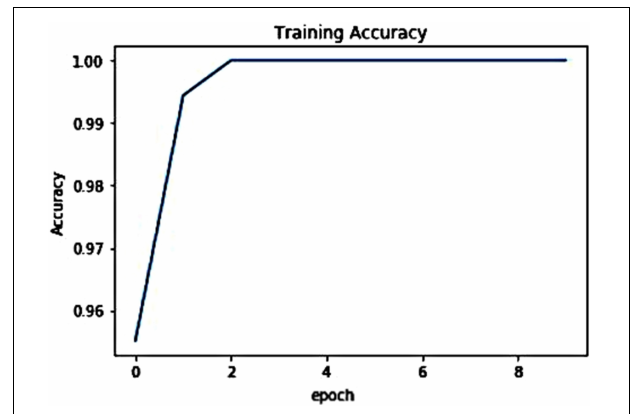
FIGURE 6 | Visual representation of training accuracy graph.